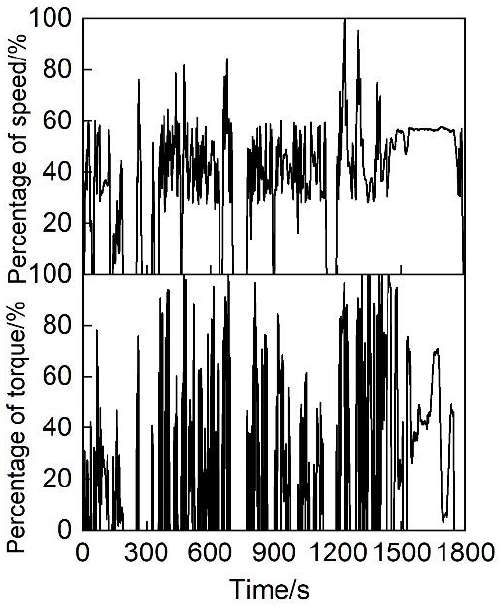
Figure 1. Schematic diagram of the WHTC cycle.